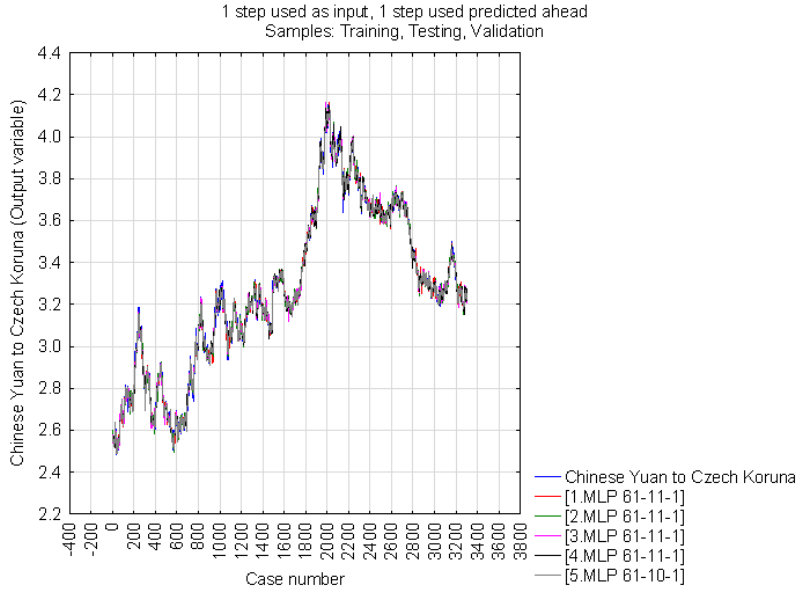
Figure 6. Actual and predicted (according to retained neural networks) development of the CZK/RMB exchange rate during the monitored period (Source: Own research).